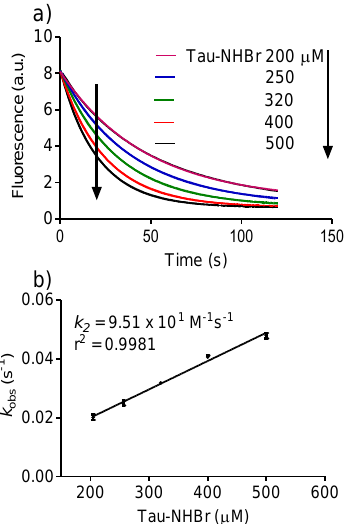
Figure 3. Reactivity of Tau-NHBr with dansylglycine. ( a ) Kinetic profile of dansylglycine consumption for determination of k obs under pseudo-first-order experimental conditions. The reaction mixture was composed of 25 µM dansylglycine (DG) and increasing concentrations of Tau-NHBr in 50 mM phosphate buffer, pH 7.0 at 25 °C. The stopped-flow system was set as follows: excitation, 360 nm LED; and emission, 475 nm cut-off filter; ( b ) Determination of k 2 for the reaction between dansylglycine and Tau-NHBr. The results are the mean of three experiments.